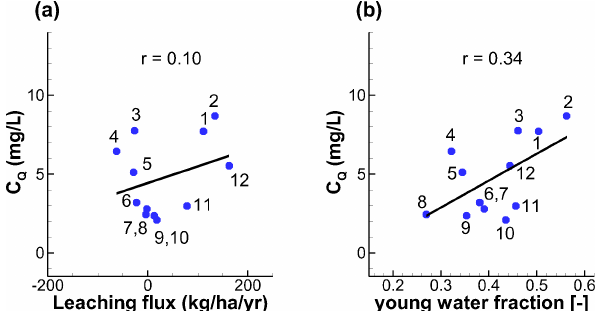
Figure 5. Comparing the monthly averaged C Q with (a) the leach- ing flux and (b) the young water fractions of Q . The black lines are linear fits of the two variables, with r being the Spearman rank correlation coefficient. The numbers refer to the